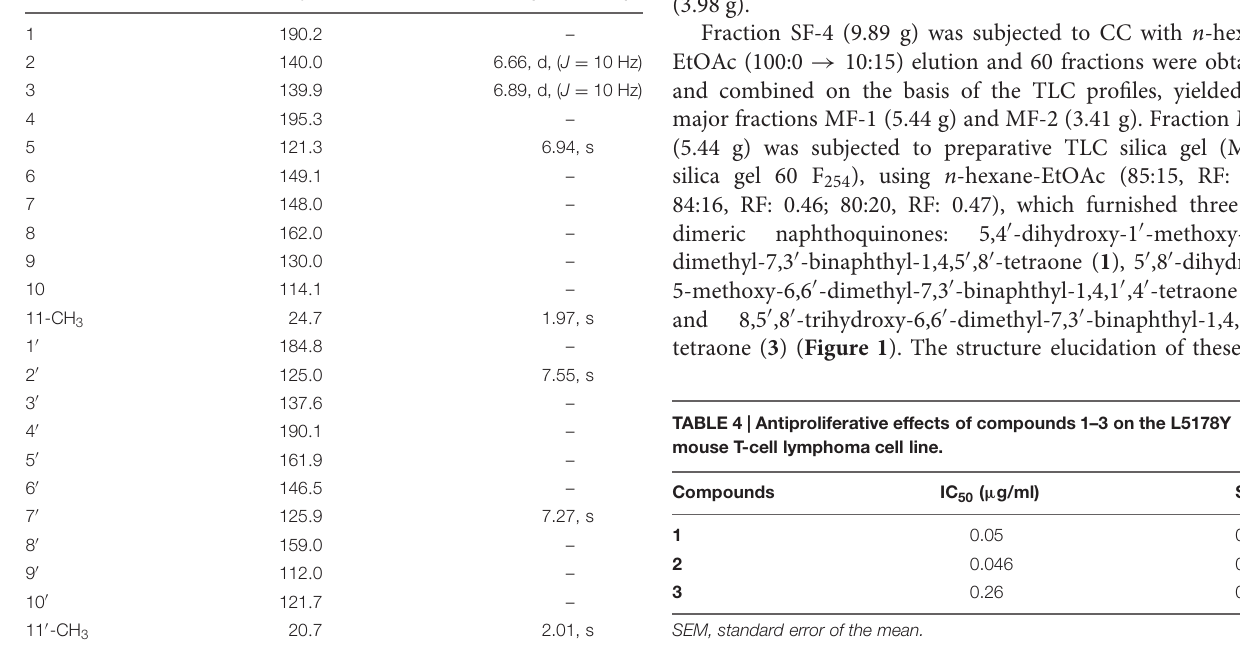
TABLE 3 | 13 C-NMR and 1 H-NMR spectral data of compound 3. Carbon no.